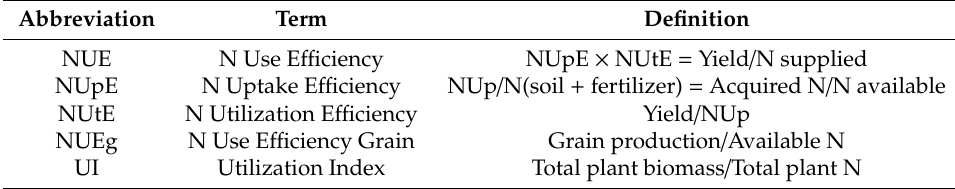
Table 1. Definitions for nitrogen use e ffi ciency (NUE) and its components